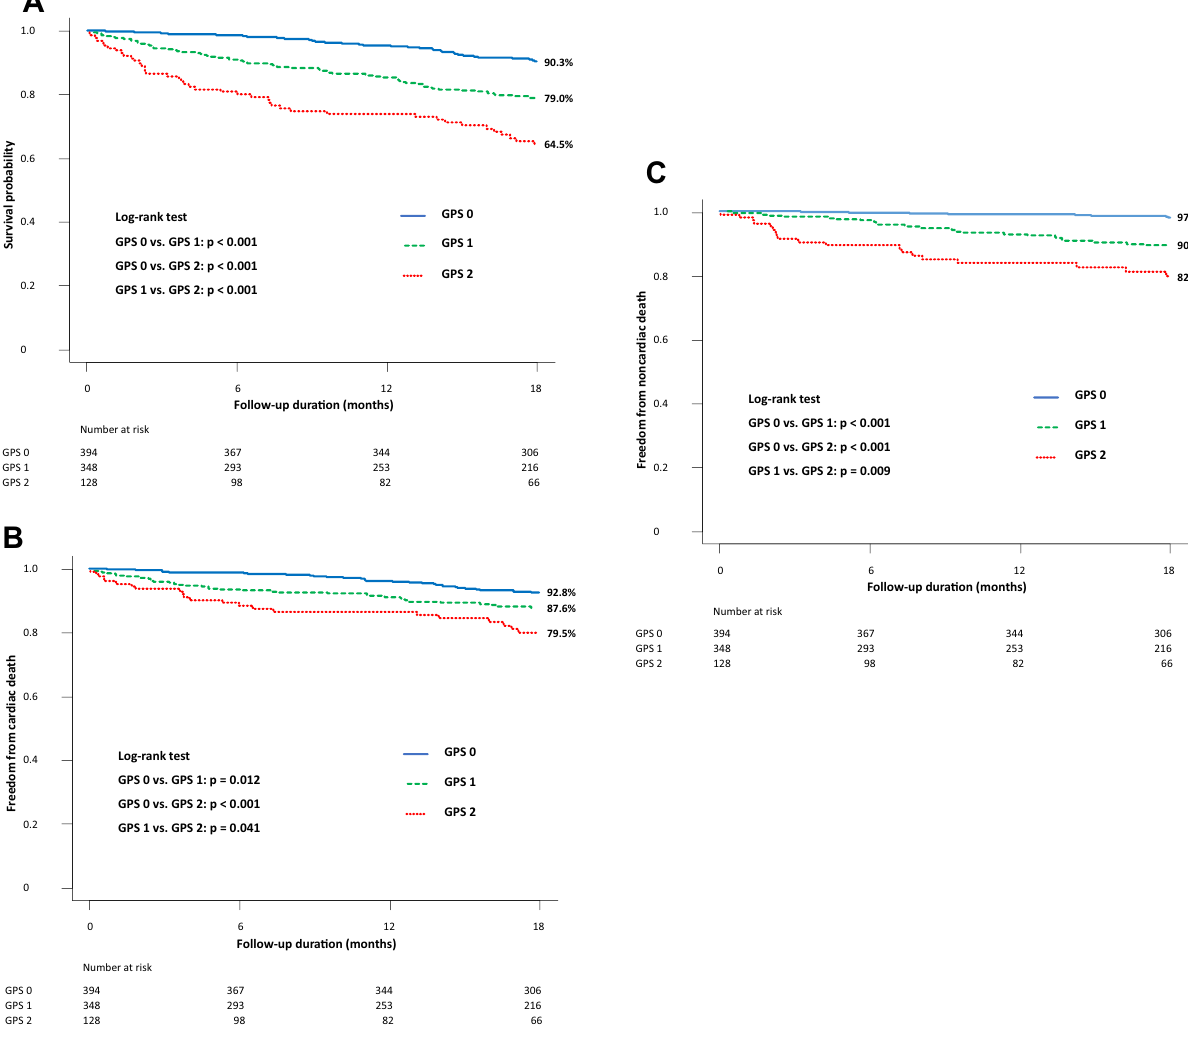
Figure 3. Kaplan–Meier survival curve of all-cause, cardiac and noncardiac mortality stratified by GPS. ( A ) Higher GPS was associated with worse prognosis in the overall cohort. With increasing the GPS, ( B ) cardiac mortality and ( C ) noncardiac mortality increased. GPS Glasgow Prognostic